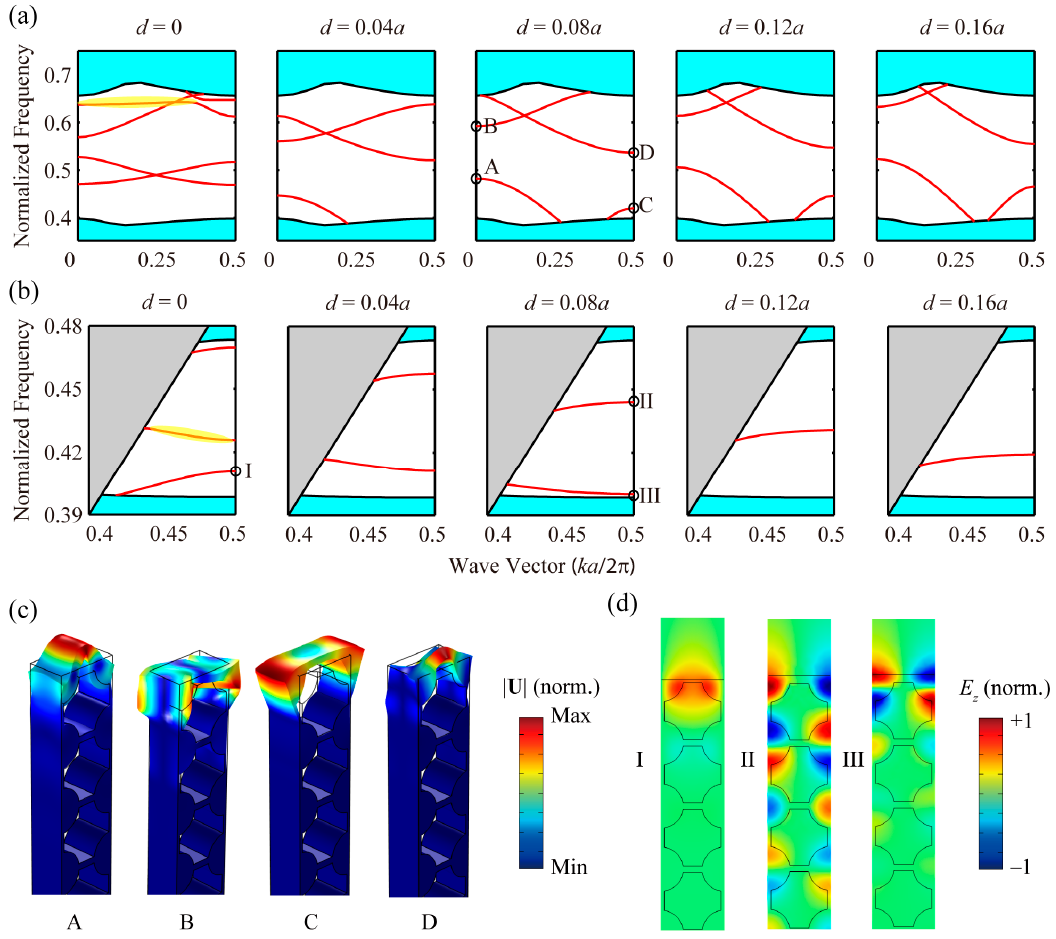
Figure 9. Dispersion curves of the surface wave bands of phononic ( a ) and photonic odd ( b ) modes for different d , where d increases from 0 to 0.16 a with a step of 0.04 a . The cyan and gray areas represent the projected bulk modes and light cone, respectively. ( c ) Displacement field distributions and deformed patterns corresponding to different phononic surface bands. ( d ) Electric field ( E Z ) distributions at plane z = 0 corresponding to different photonic surface bands.